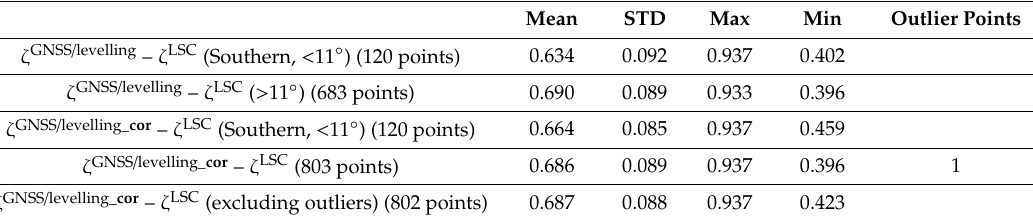
Table 4. Descriptive statistics of the di ff erences between the GNSS / levelling data corrected in Mekong Delta and GEOID_LSC. Unit: (m). Mean STD Max Min Outlier